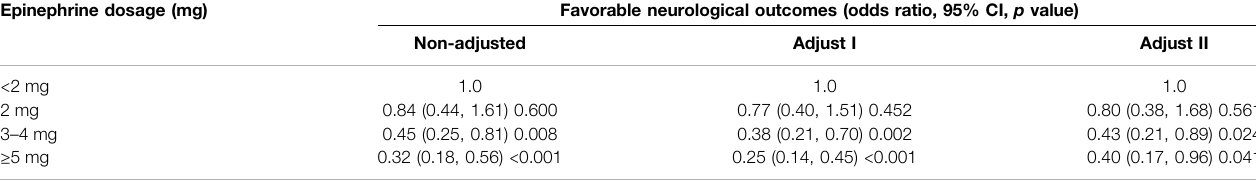
TABLE 3 | Logistic regression analysis for the association between total epinephrine dosage and neurological outcomes. Epinephrine dosage (mg) Favorable neurological outcomes (odds ratio, 95% CI, p value)